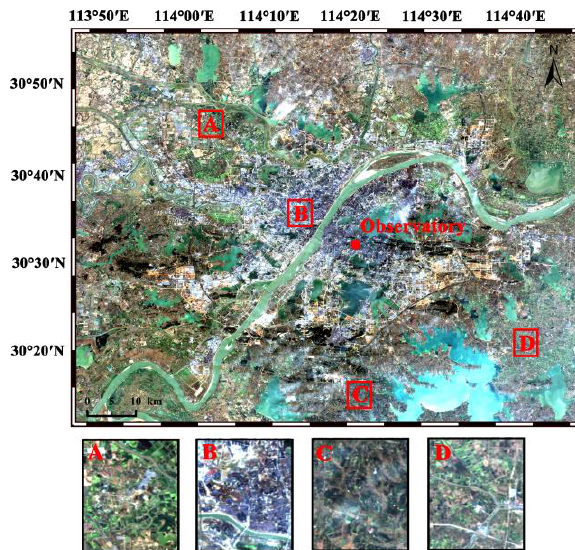
Figure 1. True colour image shows the real terrain of Wuhan obtained by the Landsat-8 in November 17, 2017. Lakes and rivers in the city release large amount of water vapor and cause a high-humid condition all around year. Sub-images show four main landcover types: (a) rural area and farmlands, (b) urban, (c) natural vegetation, (d) Suburban area.